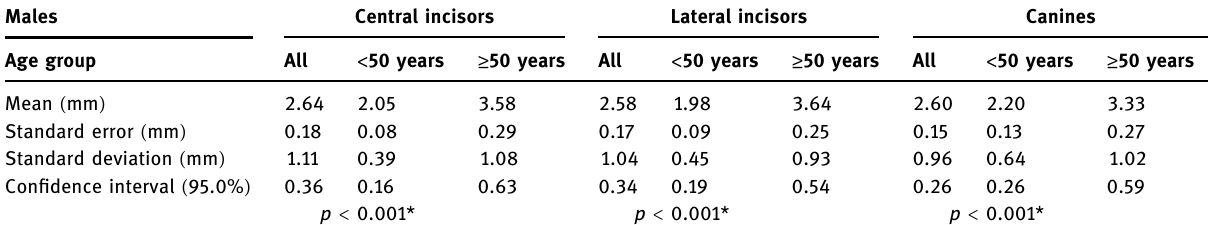
Table 4: Mean distance between the CEJ and LBC in males in all groups of examined teeth Males Central incisors Lateral incisors Canines Age group All